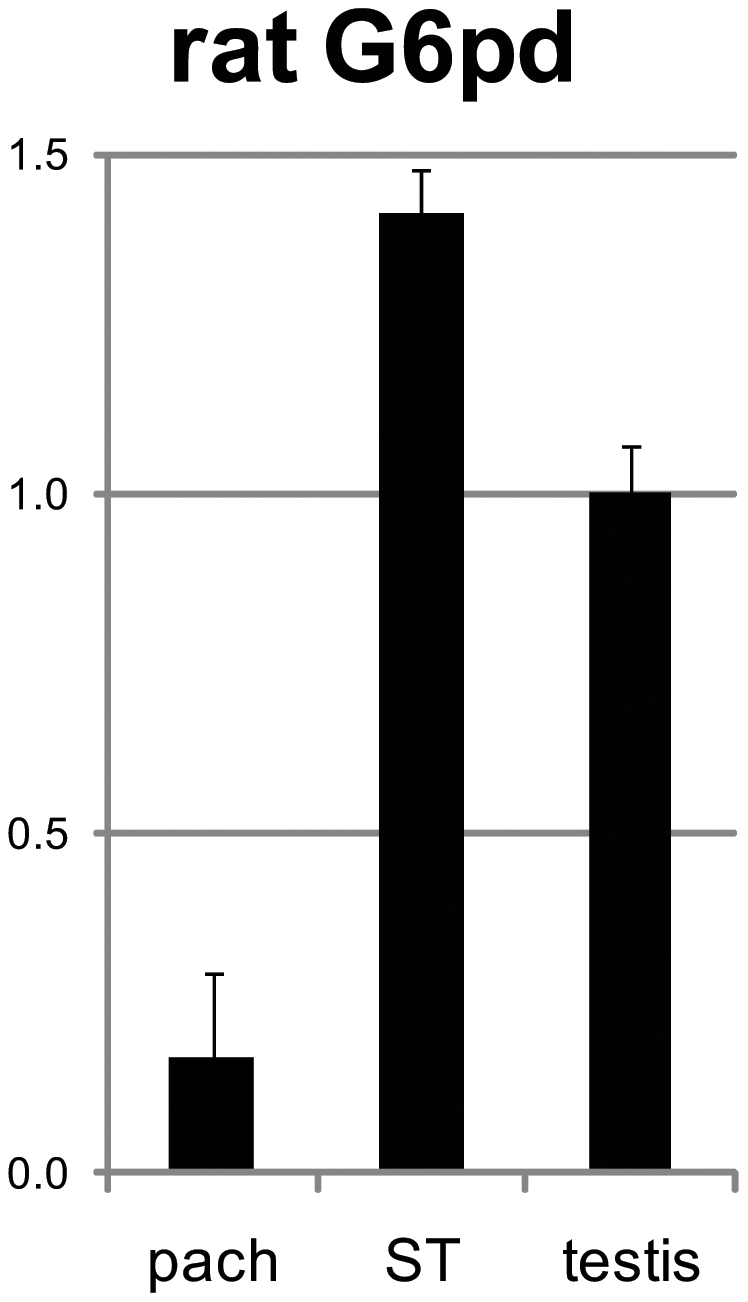
Rat X-chromosomal G6pd is postmeiotically expressed in spermatogenesis.Quantitative reverse transcriptasePCR (qRT-PCR) was performed on total RNA from testicular germ cell suspension (testis) and sorted germ cell populations of pachytene spermatocytes (pach) and spermatids (ST). G6pd is silenced in pachytene spermatocytes and reactivated postmeiotically in spermatids. Two to four replicas were used for each cell type and the expression was normalized to the expression in testicular germ cells. Standard deviations are plotted.